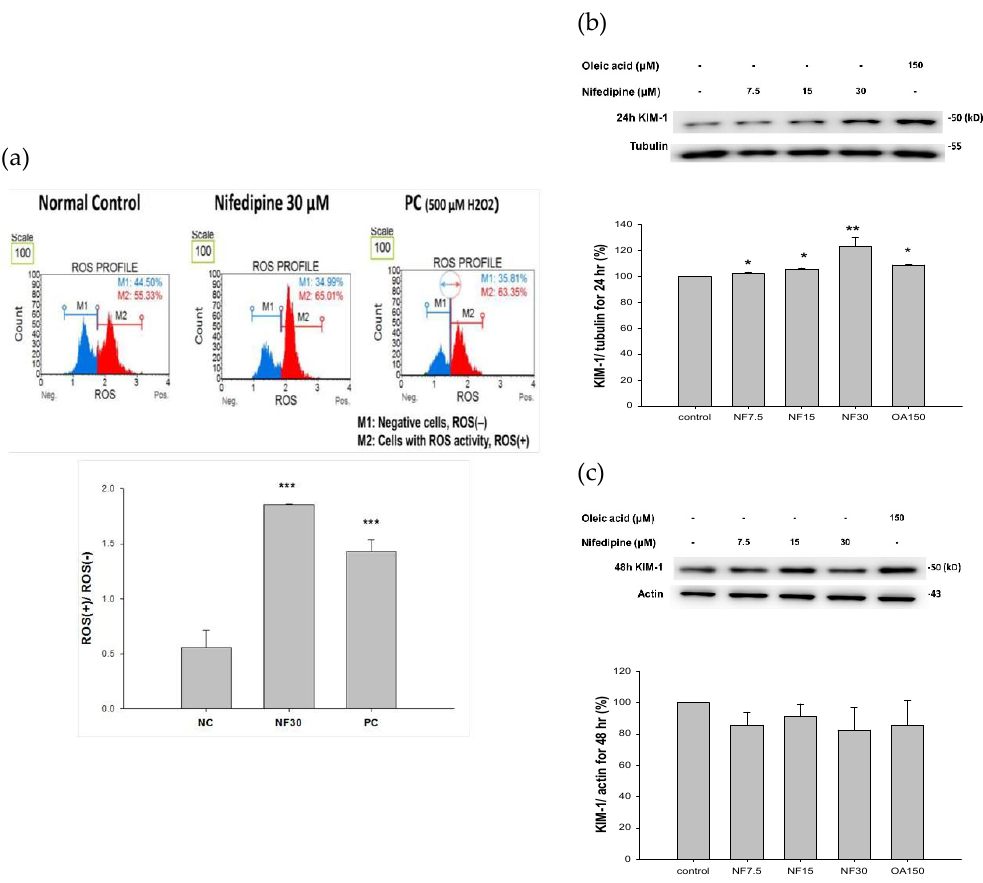
Figure 2. Nifedipine stimulated tremendous production of reactive oxygen species (ROS), and KIM-1 in 24 and 48 h. ( a ) Nifedipine 30 µ M-treated group had induced a higher ROS (3.3-fold vs. control, p < 0.01) compared to H 2 O 2 500 µ M. (2.7-fold vs. control, p < 0.01). ( b , c ) Nifedipine 7.5, 15, and 30 µ M-treated groups for 24 h (tubulin as internal control) had upregulated KIM-1 in dose dependent fashion (101%, 102%, p < 0.05, and 122%, p < 0.01 respectively) and reduced to 86%, 91%, and 80% in 48 h (actin as internal control), respectively. p -values ≤ 0.05 (marked as *) were considered statistically significant. In addition, p -values ≤ 0.01 are marked as